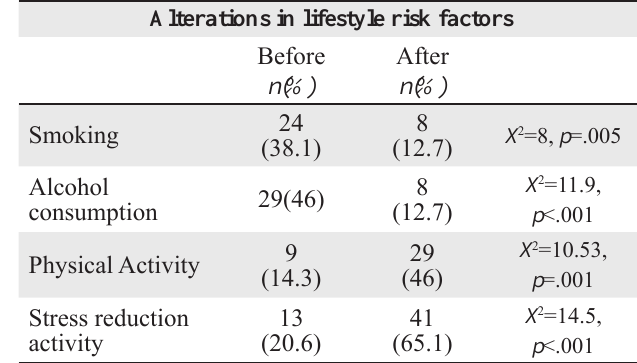
Table 6: Lifestyle risk factors before and after the diagnosis of